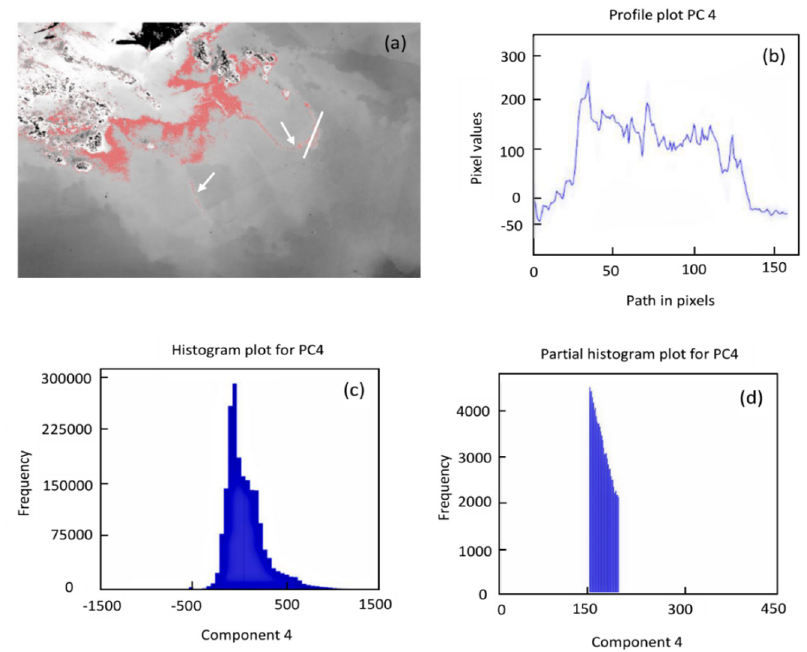
Figure 4. ( a ) The PCA component 4 was estimated from Landsat 8 bands on 3 September 2021, ( b ) Cross-section profile plot of component 4, ( c ) Component 4 histogram, ( d ) Component 4 partial histogram for predefined values.